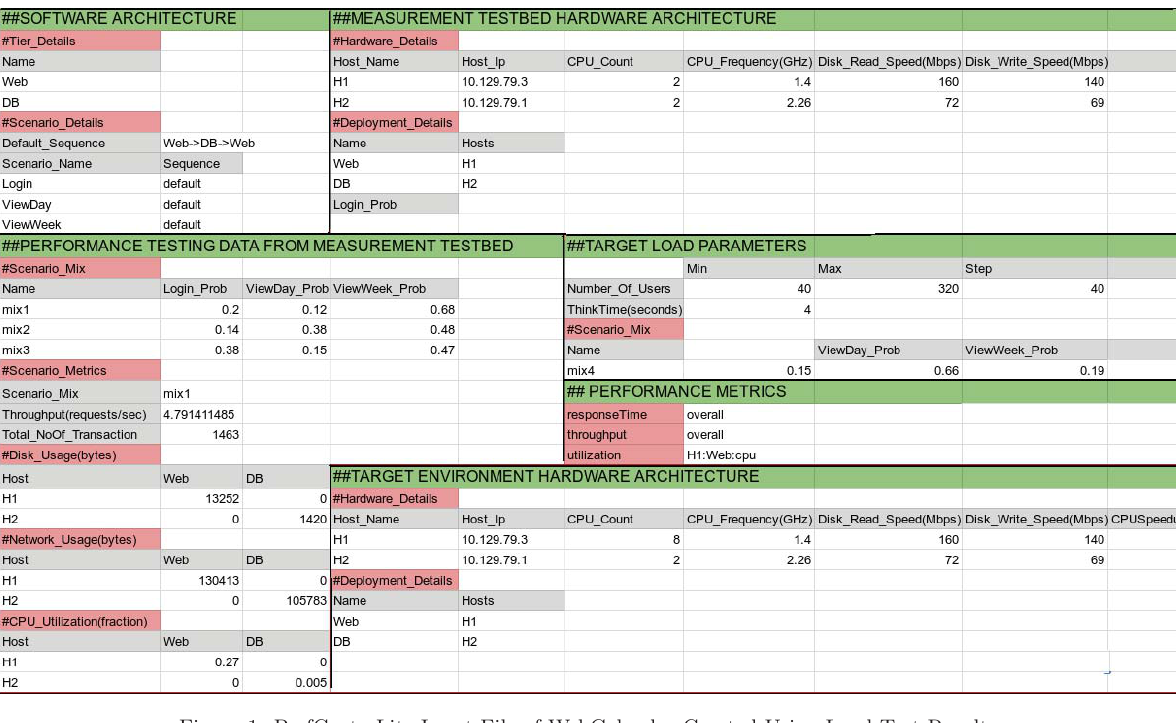
Figure 1: PerfCenterLite Input File of WebCalendar Created Using Load Test Results